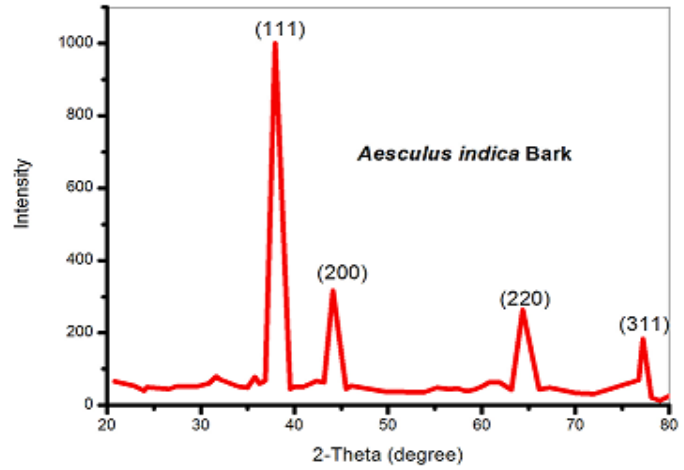
Figure 3. XRD Spectrum of AgNPs synthesized using bark’s extract of Aesculus indica .